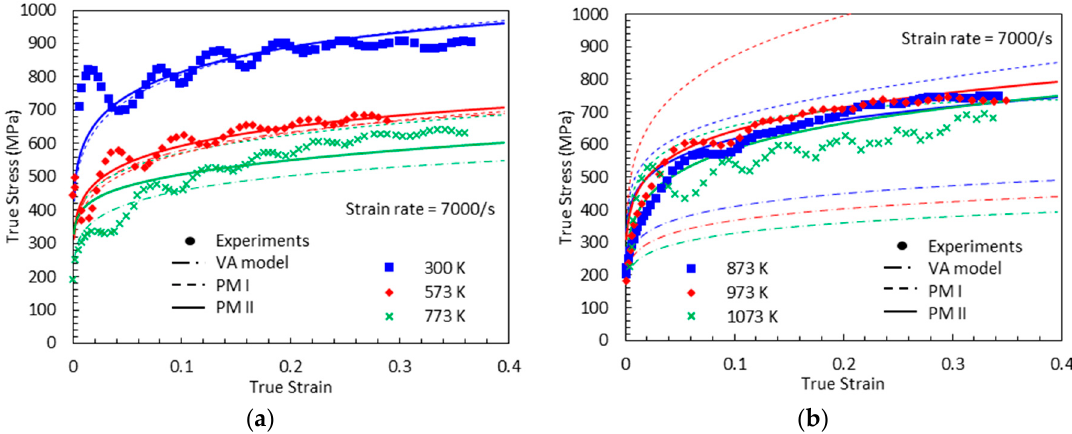
Figure 22. True stress-true strain curves from experimental measurement [1] , predictions by the VA model, PM I, and PM II with (cid:2013)(cid:4662) = 7000 (cid:1871) (cid:2879)(cid:2869) : ( a ) (cid:1846) = 300,573 and 773 (cid:1837) ( b ) (cid:1846) = 873, 973 and 1073 (cid:1837) .